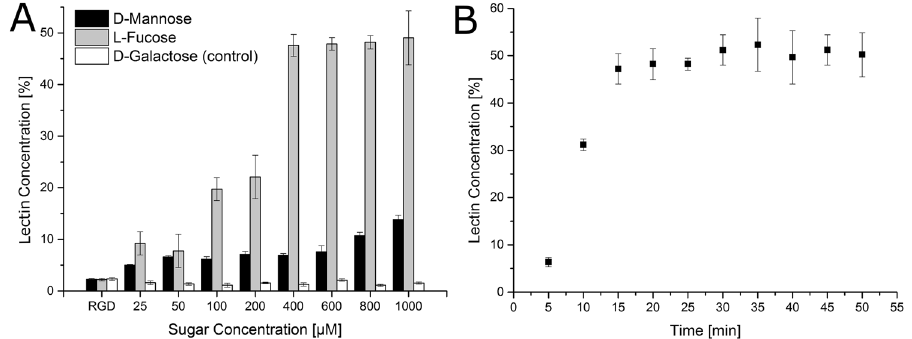
Figure 4. Lectin release from the hydrogel. To test the reversibility of YFP-LecB from the macroporous hydrogel matrix, gels were decorated with YFP-LecB. Afterwards, decorated hydrogels were incubated with different concentration (0–1000 µ M) of lectin binding sugars (D-mannose, L-fucose and D-galactose). After 2 h, the YFP-LecB concentration was measured via fluorescence in the supernatant. ( B ) To investigate the time which is needed to elute lectin from the hydrogel, hydrogels decorated with YFP-LecB were incubated with 400 µ M of L-fucose and at regular intervals samples were taken from the supernatant and analysed for YFP- LecB fluorescence. All bars represent the standard